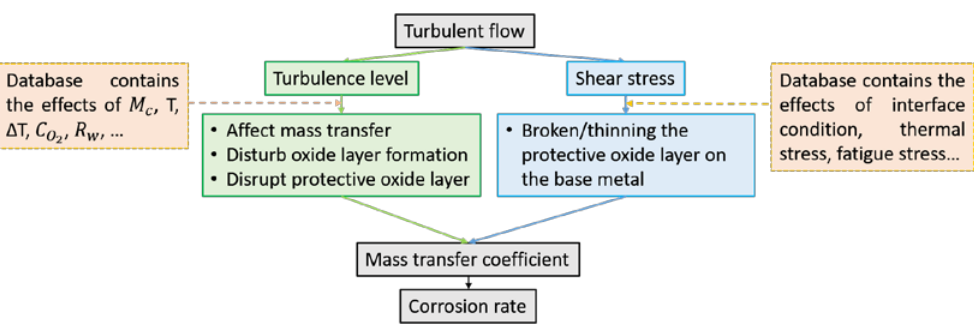
Figure 2. Schematic of the effects of turbulent flow on the corrosion rate of the base metal.